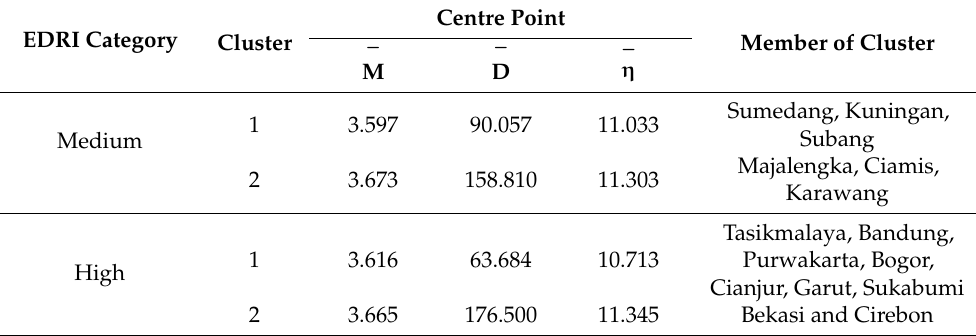
Table 5. The results of clustering type I.